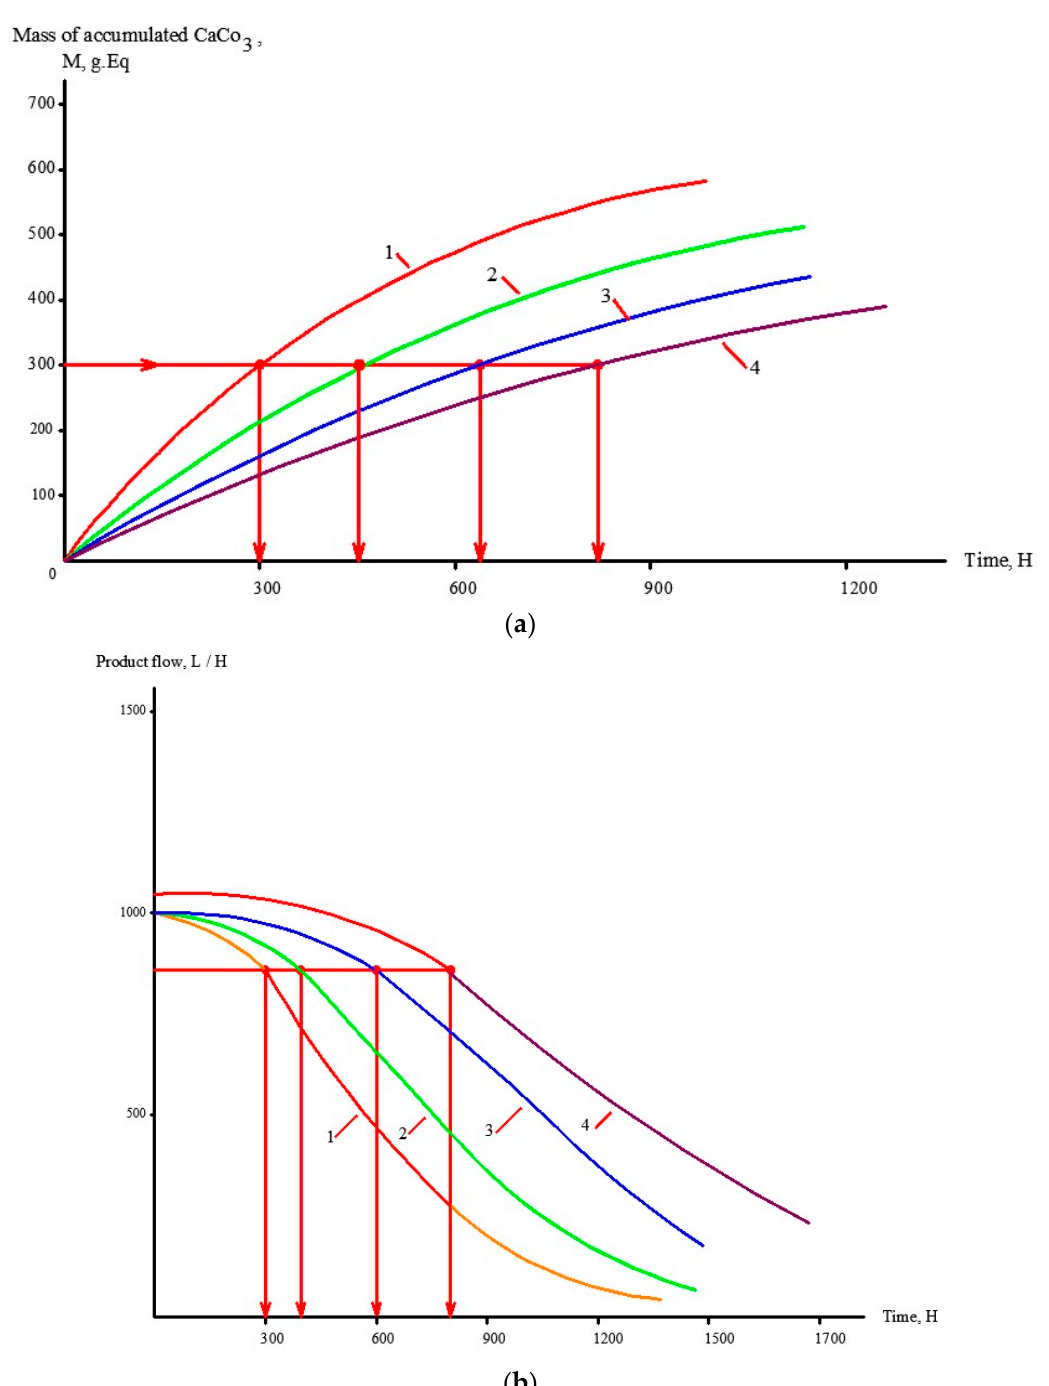
Figure 6. Prediction of membrane product flow decrease with calcium carbonate accumulation over time and recommended time between membrane cleanings: ( a )—dependencies of accumulated calcium carbonate amount on time; ( b ) dependencies of product flow on time; 1—Jurby-Soft, 5 ppm; 2—Jurby-Soft, 10 ppm; 3—Aminat-K, 5 ppm; 4—Aminat-K, 10 ppm.